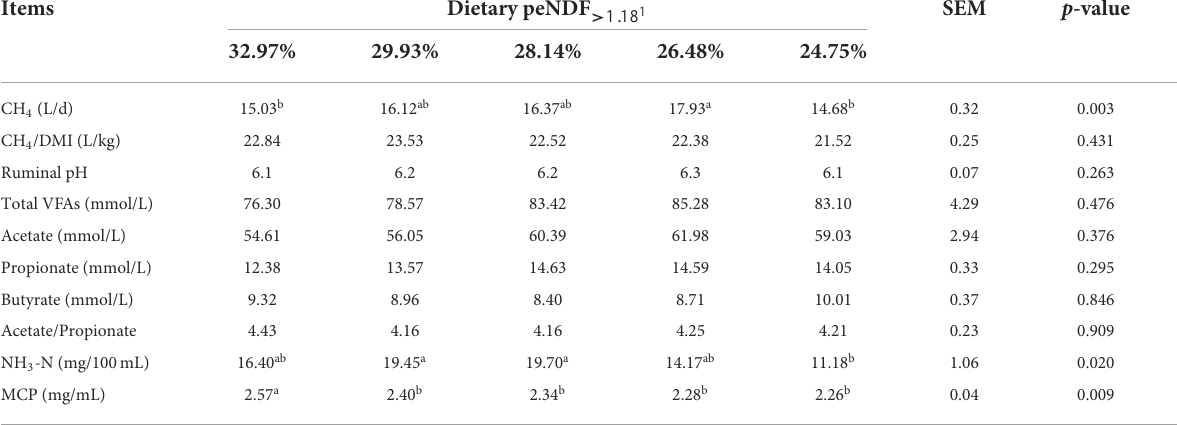
TABLE 5 Effects of different contents of peNDF > 1.18 in diets on ruminal fermentation characteristics in goats.